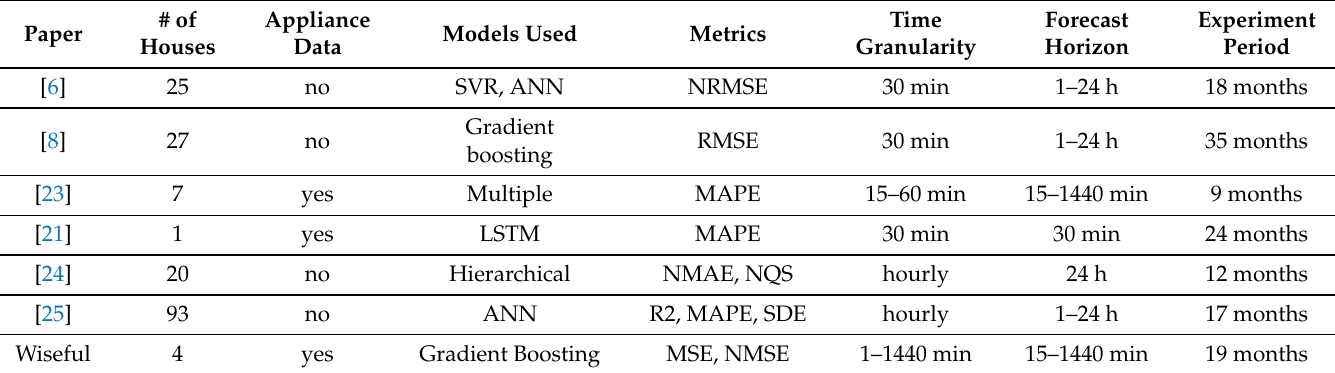
Table 5. Residential consumption forecasting papers